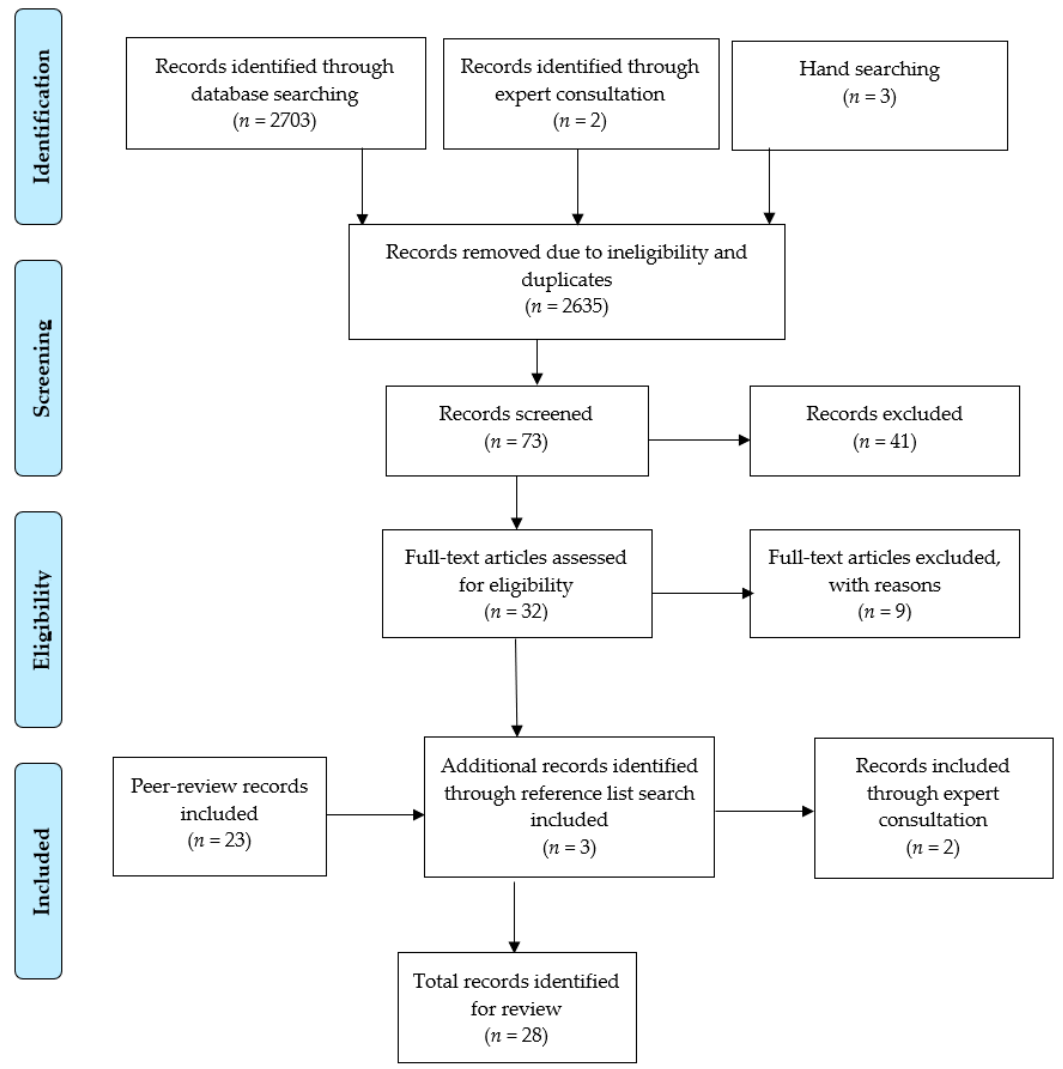
Figure 1. PRISMA study selection flow chart regarding parents. Table 2. Literature regarding the development of physical activity messages targeting parents.